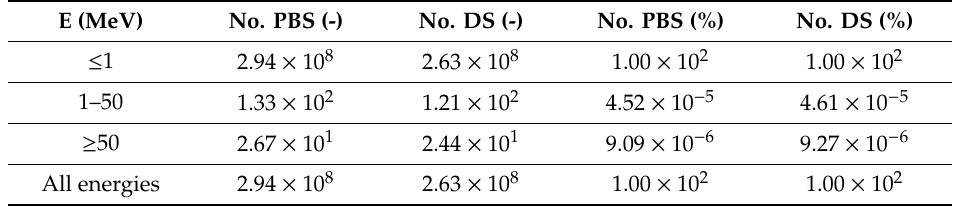
Table 3. Summarized neutron production at Position 2 and their categorization according to the ICRP 103 report